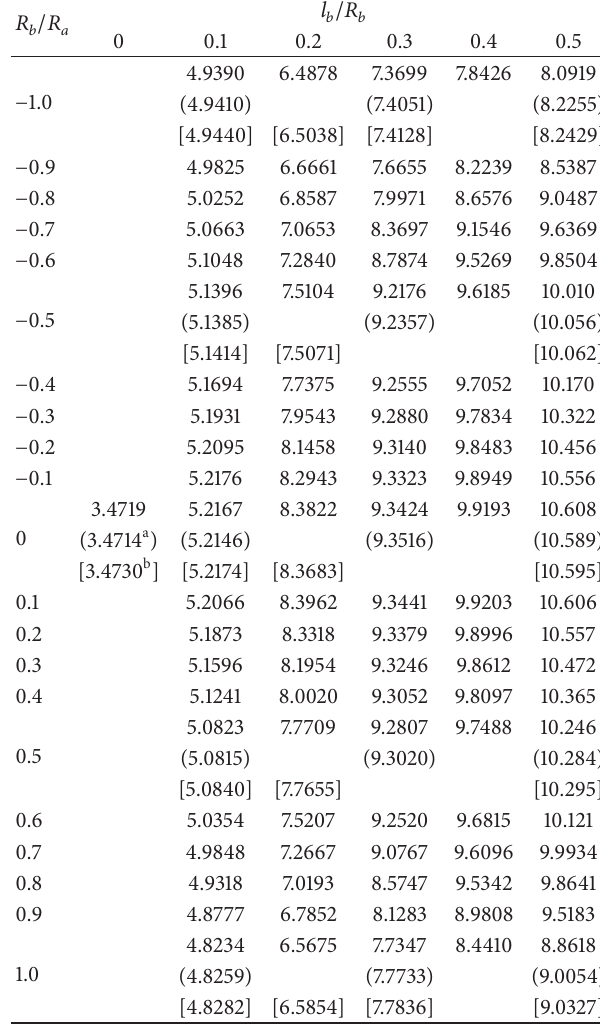
Table 9: The first frequency parameters of C-F-F-F shallow